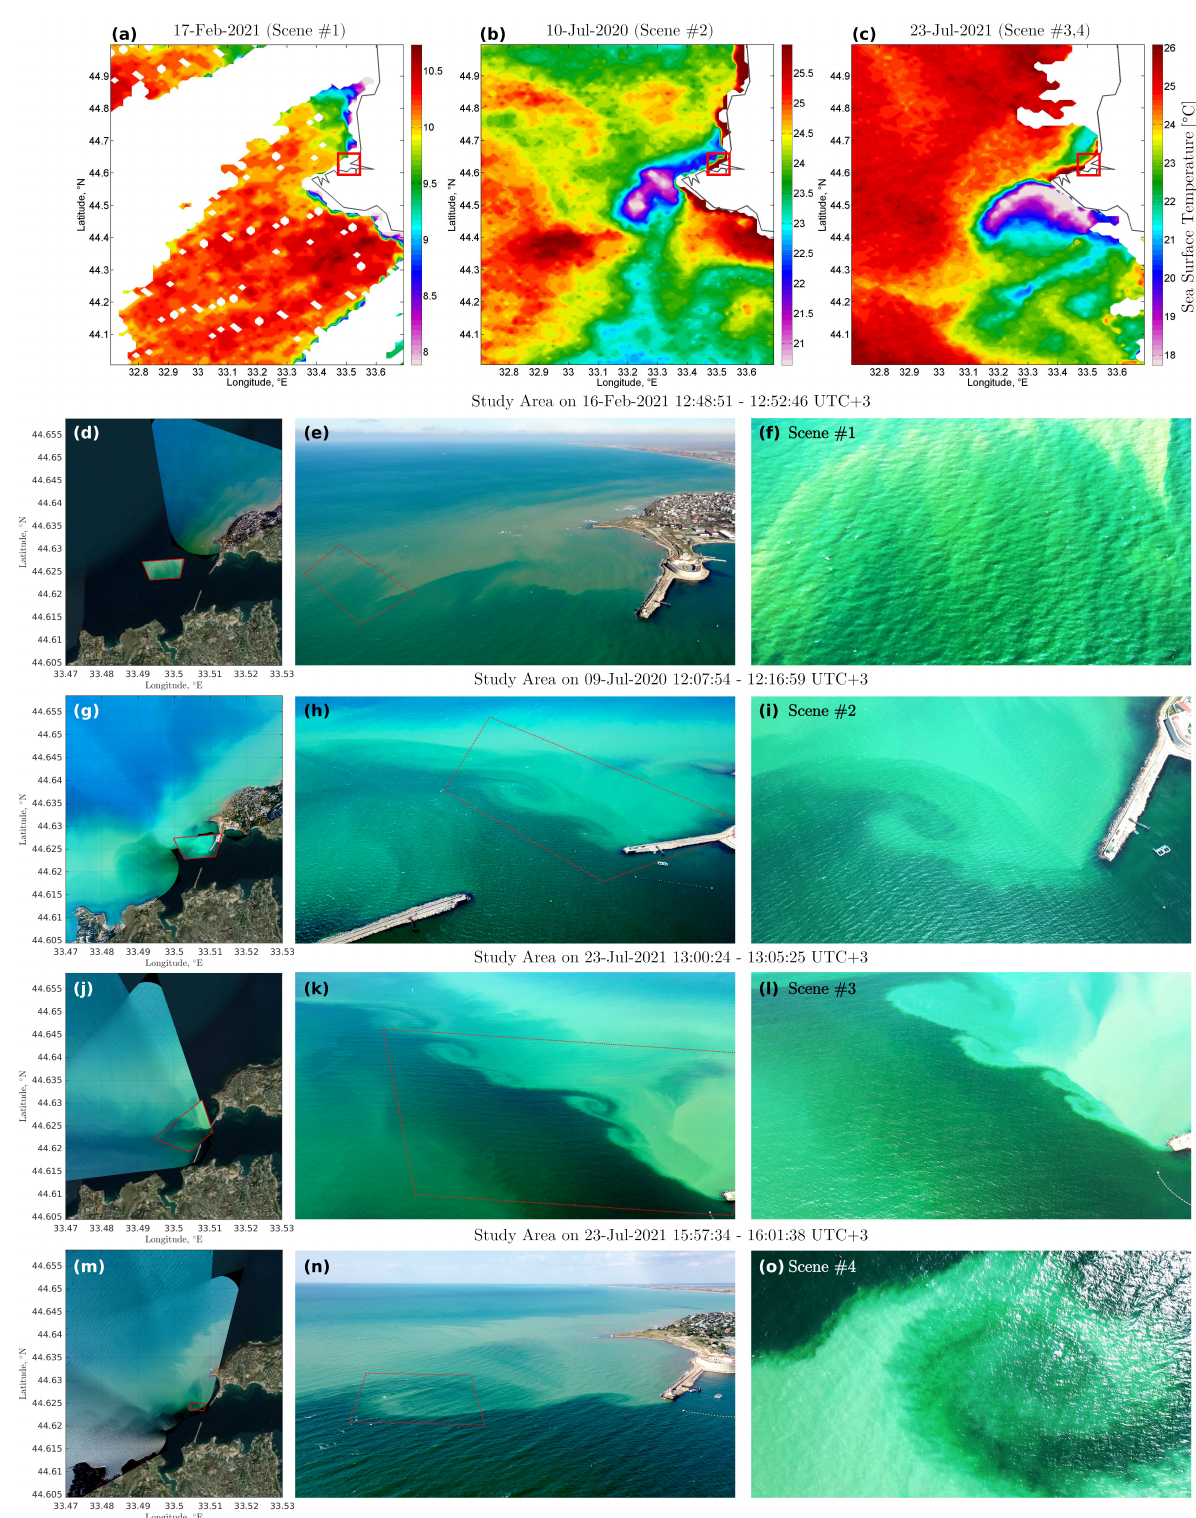
Figure 1. The Aqua/MODIS sea surface temperature maps on the measurement day (or a day after with a better cloud mask) for ( a ) Scene #1; ( b ) Scene #2; and ( c ) Scenes #3,4. The study areas are shown by red boxes. The georeferenced UAV images for: ( d )—Scene #1; ( g )—Scene #2; ( j )—Scene #3; and ( m )—Scene #4. A snapshot taken when the UAV approached the scene: ( e )—Scene #1; ( h )—Scene #2; ( k )—Scene #3; and ( n )—Scene #4. A frame from the processed quasi-stationary interval: ( f )—Scene #1; ( i )—Scene #2; ( l )—Scene #3; and ( o )—Scene